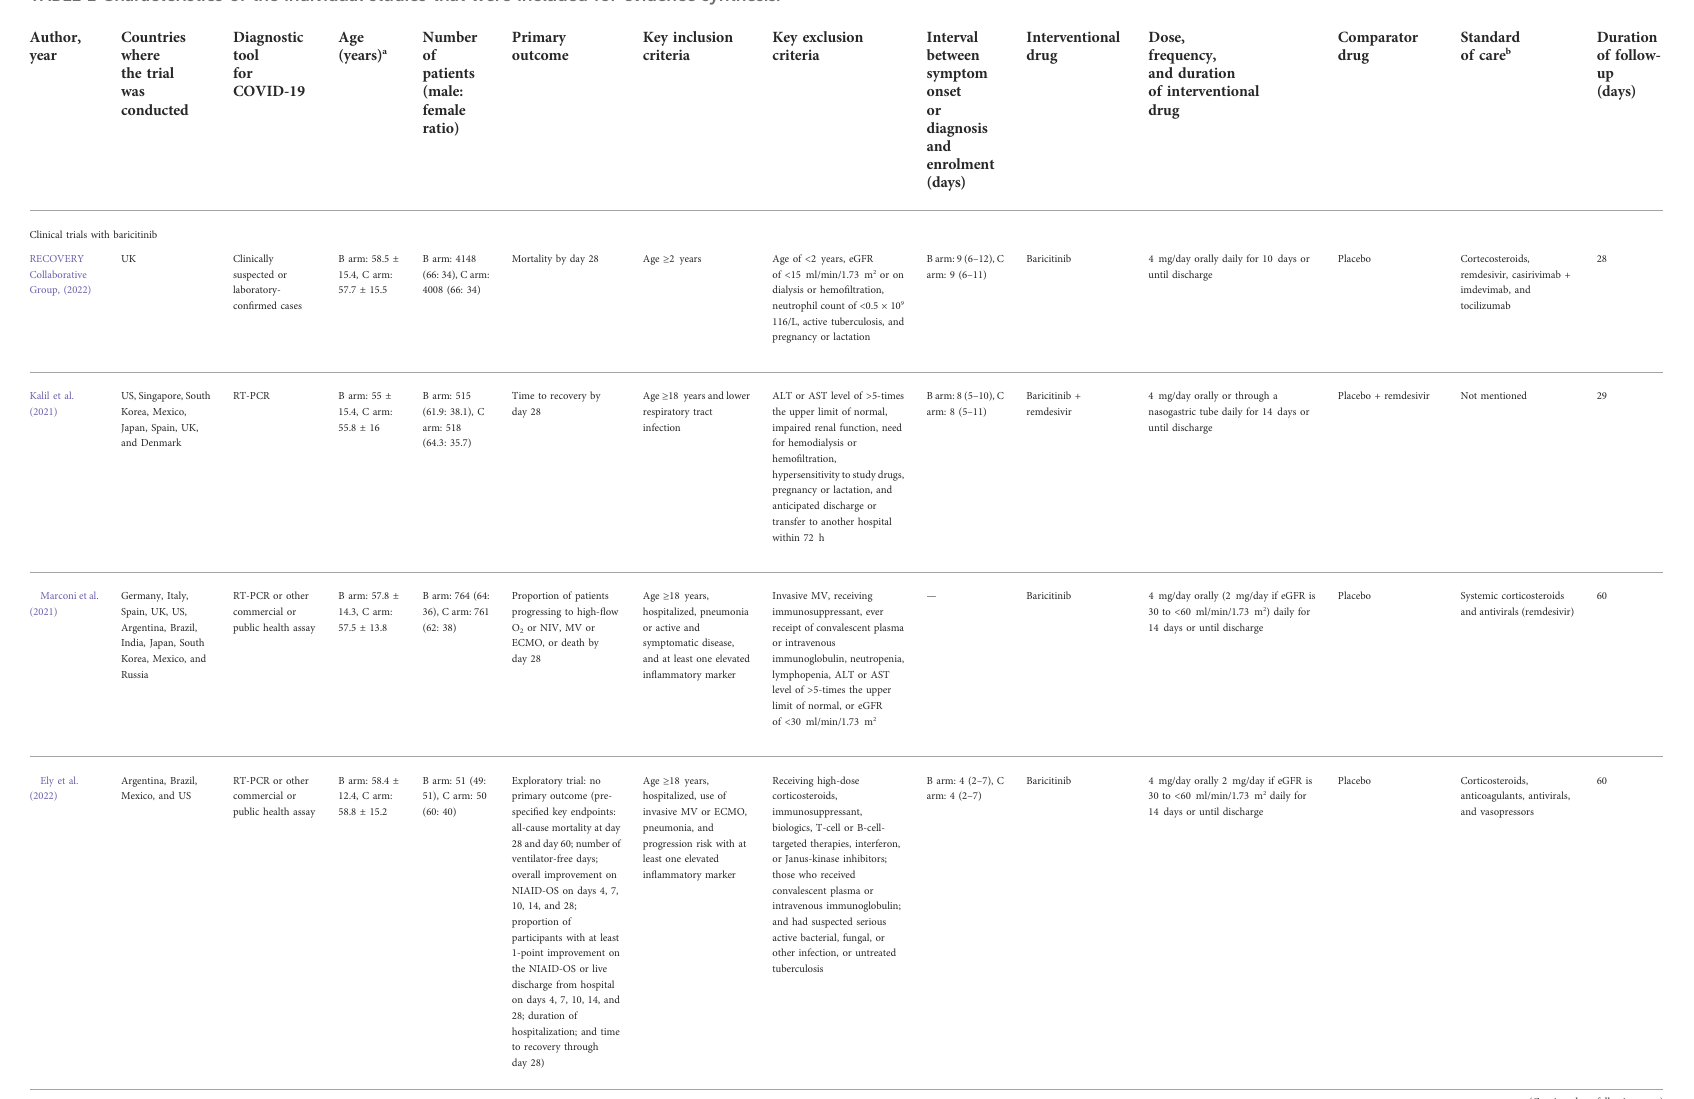
TABLE 1 Characteristics of the individual studies that were included for evidence